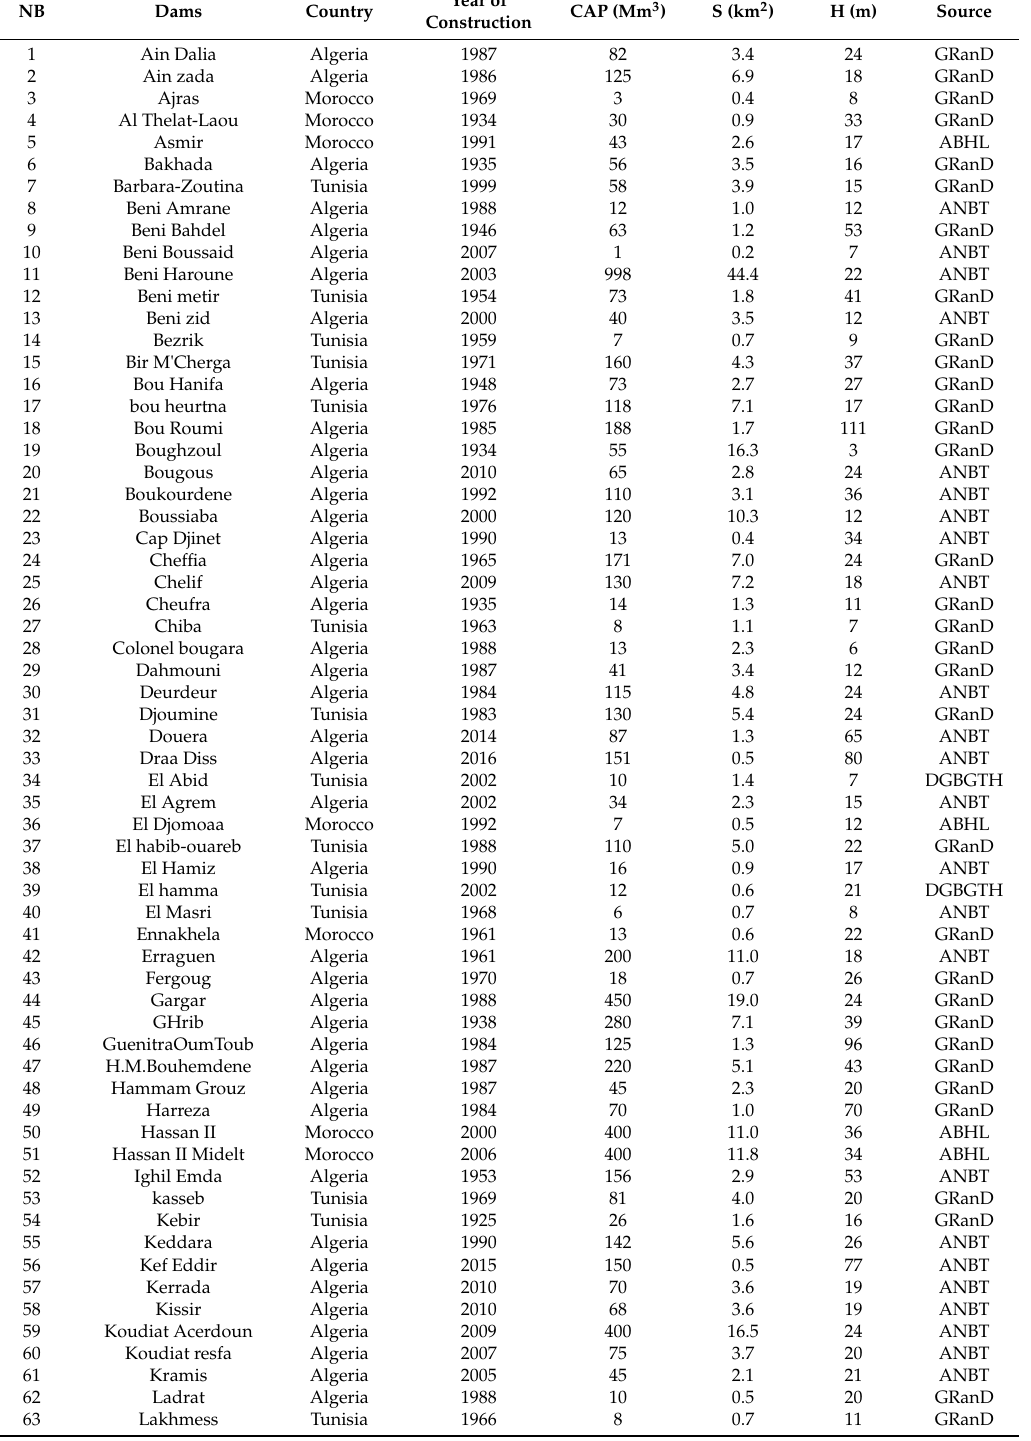
Table 1. Characteristics of the 101 dams of the Mediterranean Maghreb Basin (MMB) considered in this study.